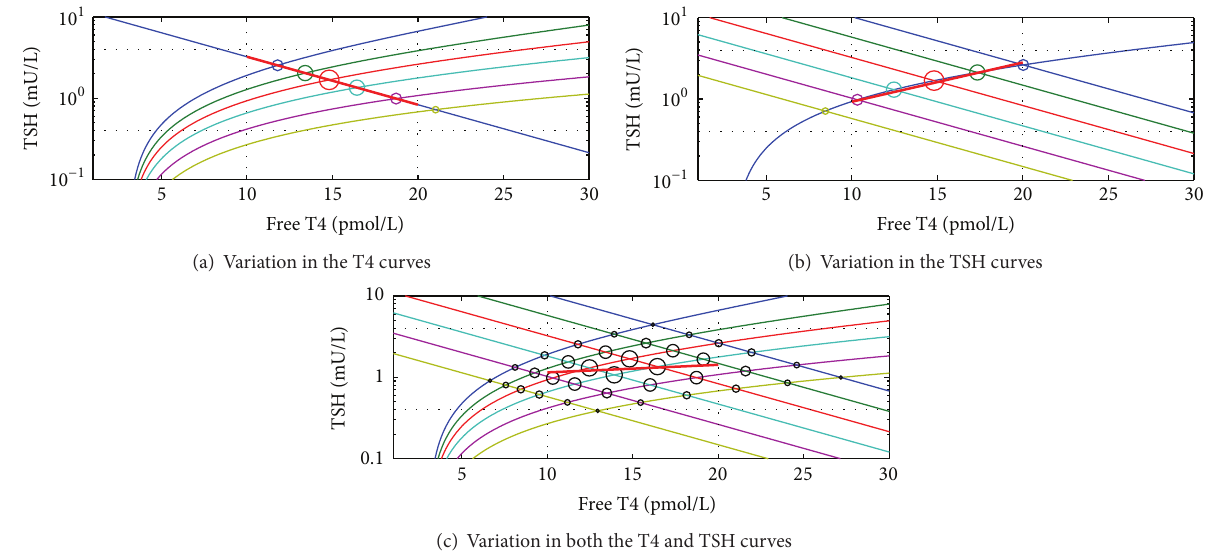
Figure 4: (a) shows a population in which interindividual T4 curve variation is greater than interindividual TSH curve variation (the extreme exampleofonlyoneTSHcurveintersectingwithmultipleT4curvesisshown),(b)showstheconverse,oneT4curveintersectingwithmultiple TSH curves, and (c) shows a population in which T4 and TSH curve variation are similar (there are multiple T4 and multiple TSH curves and more intersection points). In these graphs the intersection points are marked by circles of different sizes to indicate a typical distribution of the curves and the larger circles indicate that more individuals are expected to lie in the centre of the range as compared to the extremities. The lines of best fit (thick red lines) are drawn such that the differences in the possible slopes of the lines of best fit (the different population curves) are